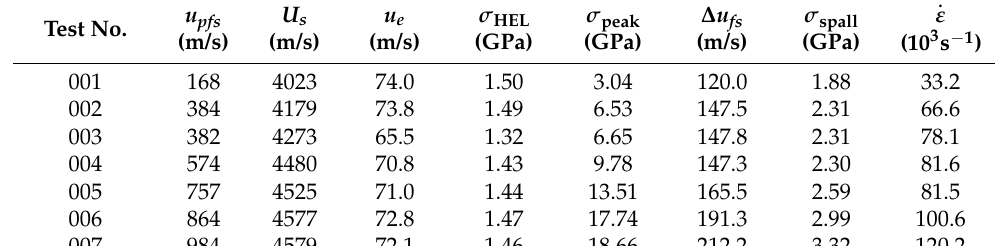
Table 3. Experimental results for the HSLA obtained by plate impact test. Test No.